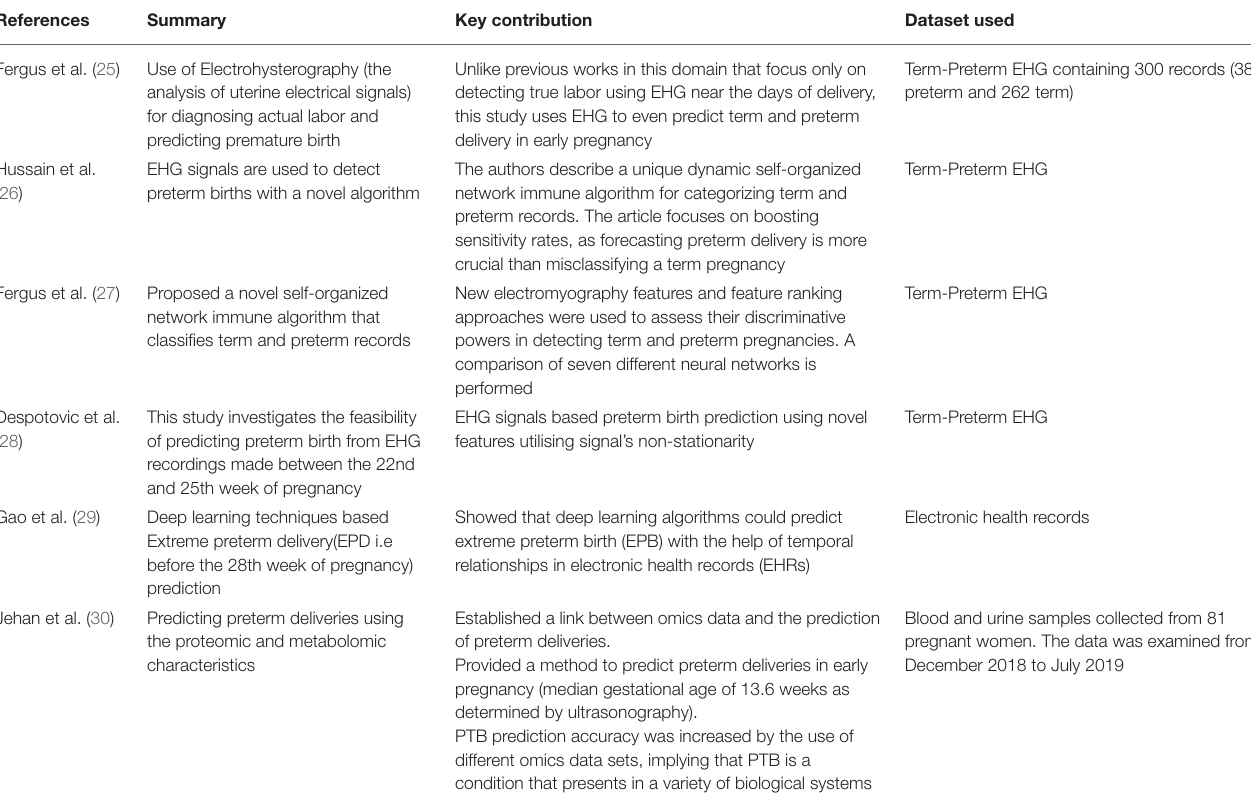
TABLE 3 | Summary of approaches used to predict risk of preterm